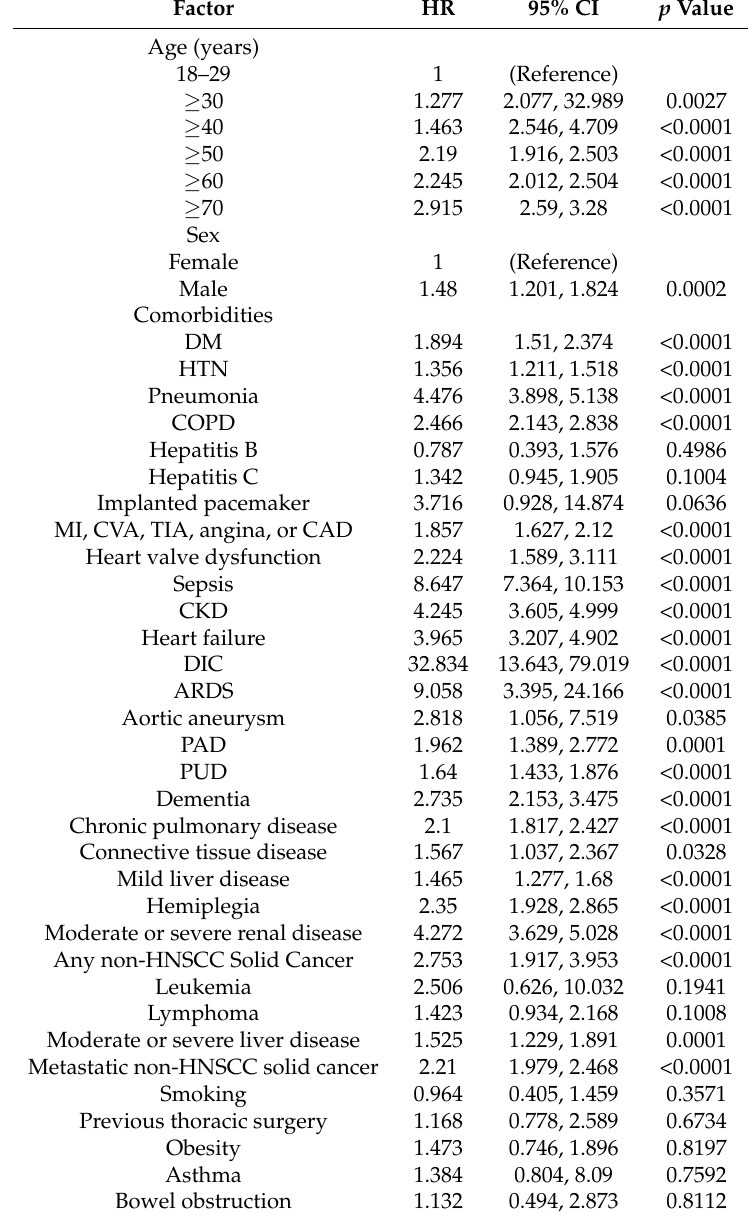
Diabetes mellitus: DM; hypertension: HTN; Chronic Obstructive Pulmonary Disease: COPD; Hepatitis B: HBV; Hepatitis C: HCV; myocardial infarction: MI; cerebral vascular accident: CVA; transient ischemic attack: TIA; coronal arterial disease: CAD; end stage renal disease: ESRD; Chronic kidney disease: CKD; disseminated intravascular coagulation: DIC; adult respiratory distress syndrome: ARDS; peripheral vascular disease: PVD; peptic ulcer disease: